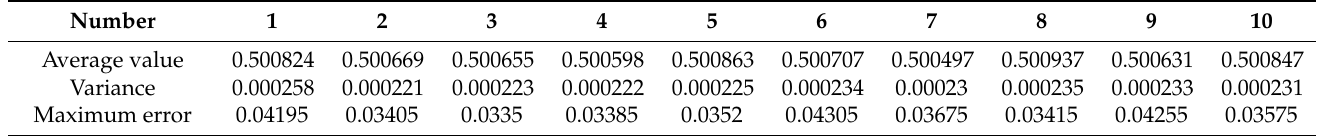
Table 3. The statistical analysis of the neuron stretch device with 0.5 rpm rotation